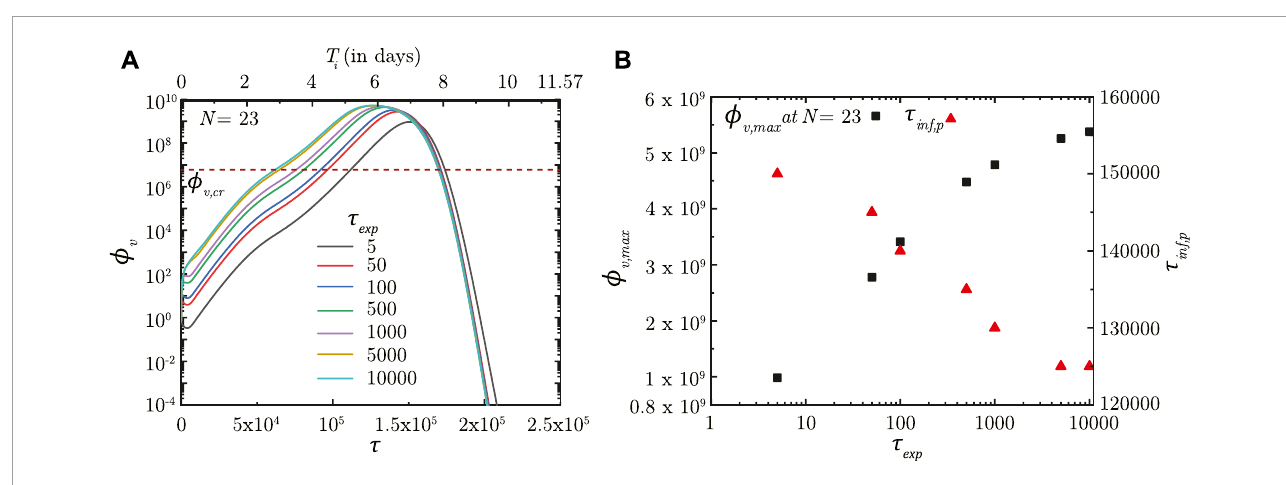
FIGURE 4 (A) Temporal change in dimensionless virus concentration ( ϕ v ) at N = 23 (deep lung) for different exposure durations ( τ exp ) with respect to dimensionless time ( τ ) as well as a dimensional time ( T i ) post infection onset. The breathing time period ( T b = 4s) is considered for obtaining the dimensional time (see Eq. 7 ). (B) Change in peak dimensionless virus concentration ( ϕ v ,max ) and time required for reaching peak infection ( τ inf, p ) in the deep lung with varying τ exp . The dotted line indicates the critical viral load ( ϕ v , cr ) in the deep lung required for pneumonia onset (Fajnzylber et al., 2020; Wölfel et al.,